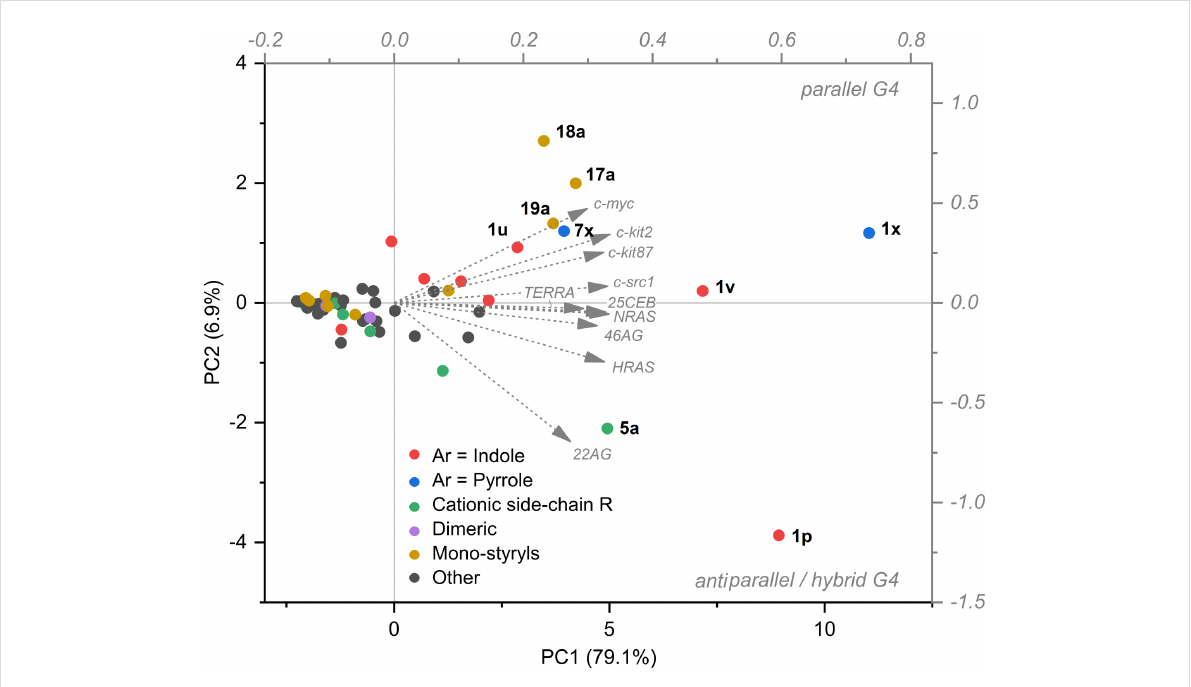
Figure 7: PC1 vs PC2 plot obtained from the principal component analysis of the light-up data matrix for all dyes ( ct DNA and cl RNA were excluded, as well as TBA and c-myb due to their low light-up factors). Color coding highlights the distribution of the dyes sharing similar structural